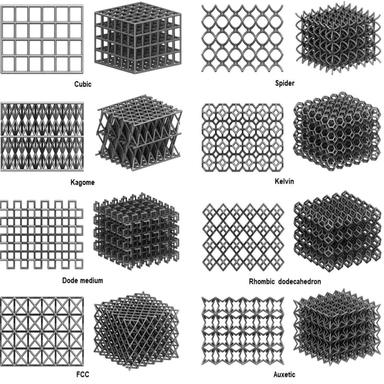
Computer–aided design (front and isometric views) of the different lattice structures used in this study.